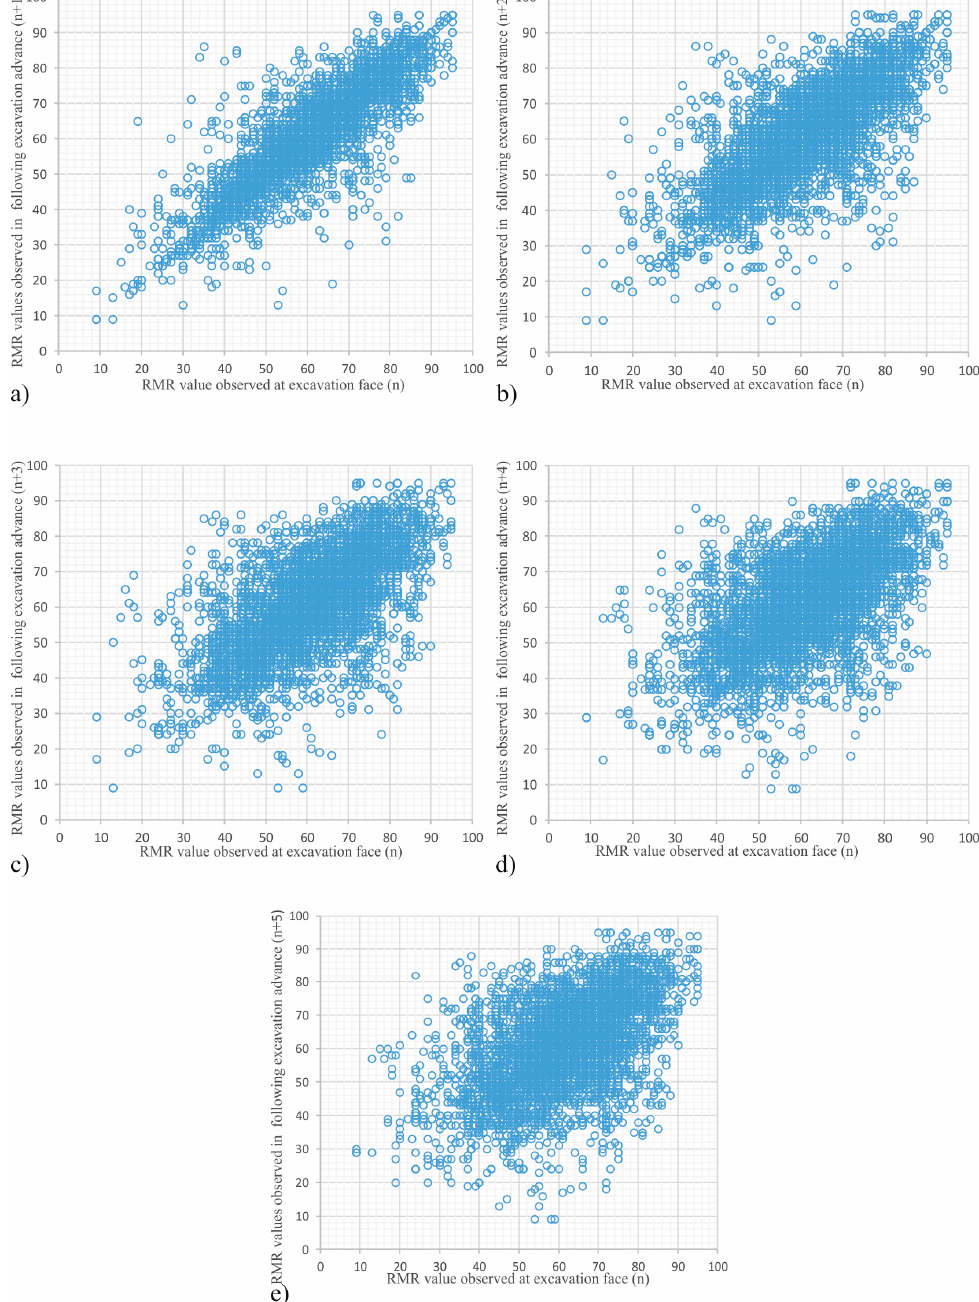
Figure 8. RMR values observed in the following excavation advances considering the RMR value at the current excavation face ( n ): ( a ) for the n + 1 excavation advance; ( b ) for the n + 2 excavation advance; ( c ) for the n + 3 excavation advance; ( d ) for the n + 4 excavation advance; and, ( e ) for the n + 5 excavation advance.